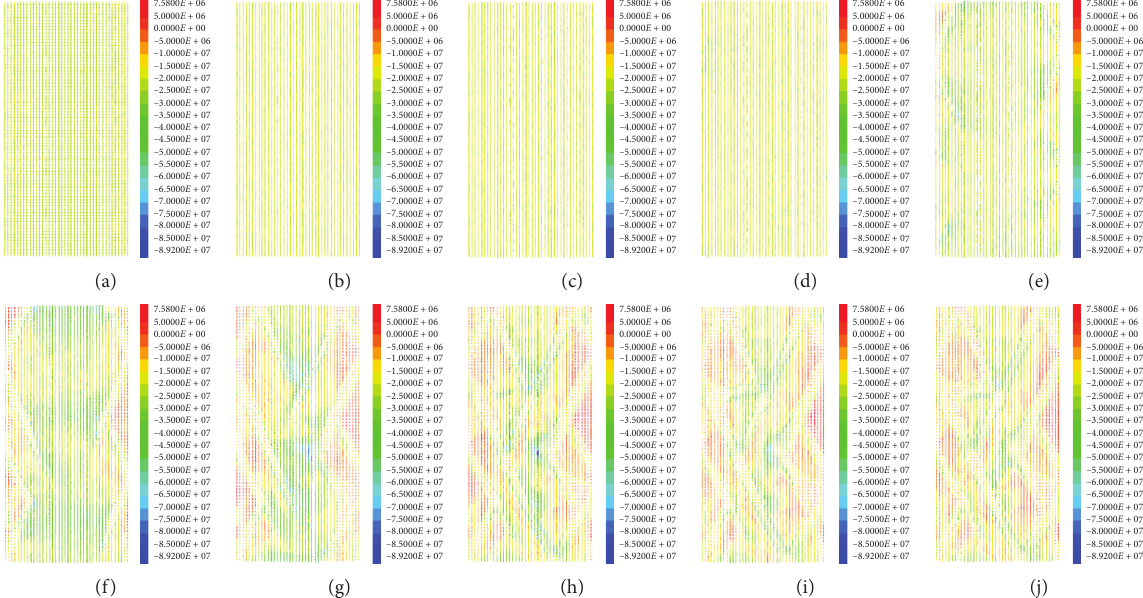
Figure 14: Minimum principal stress (Pa) evolvement at different stress level in simulated triaxial compression test under confining pressure of 20 MPa.